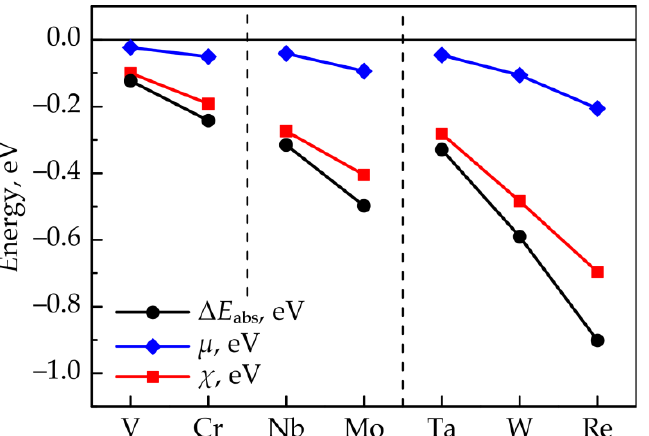
Figure 8. Change in the oxygen absorption energy due to doping ( Δ E abs ) by a single atom, decom- posed into mechanical ( μ ) and chemical ( χ ) contributions.